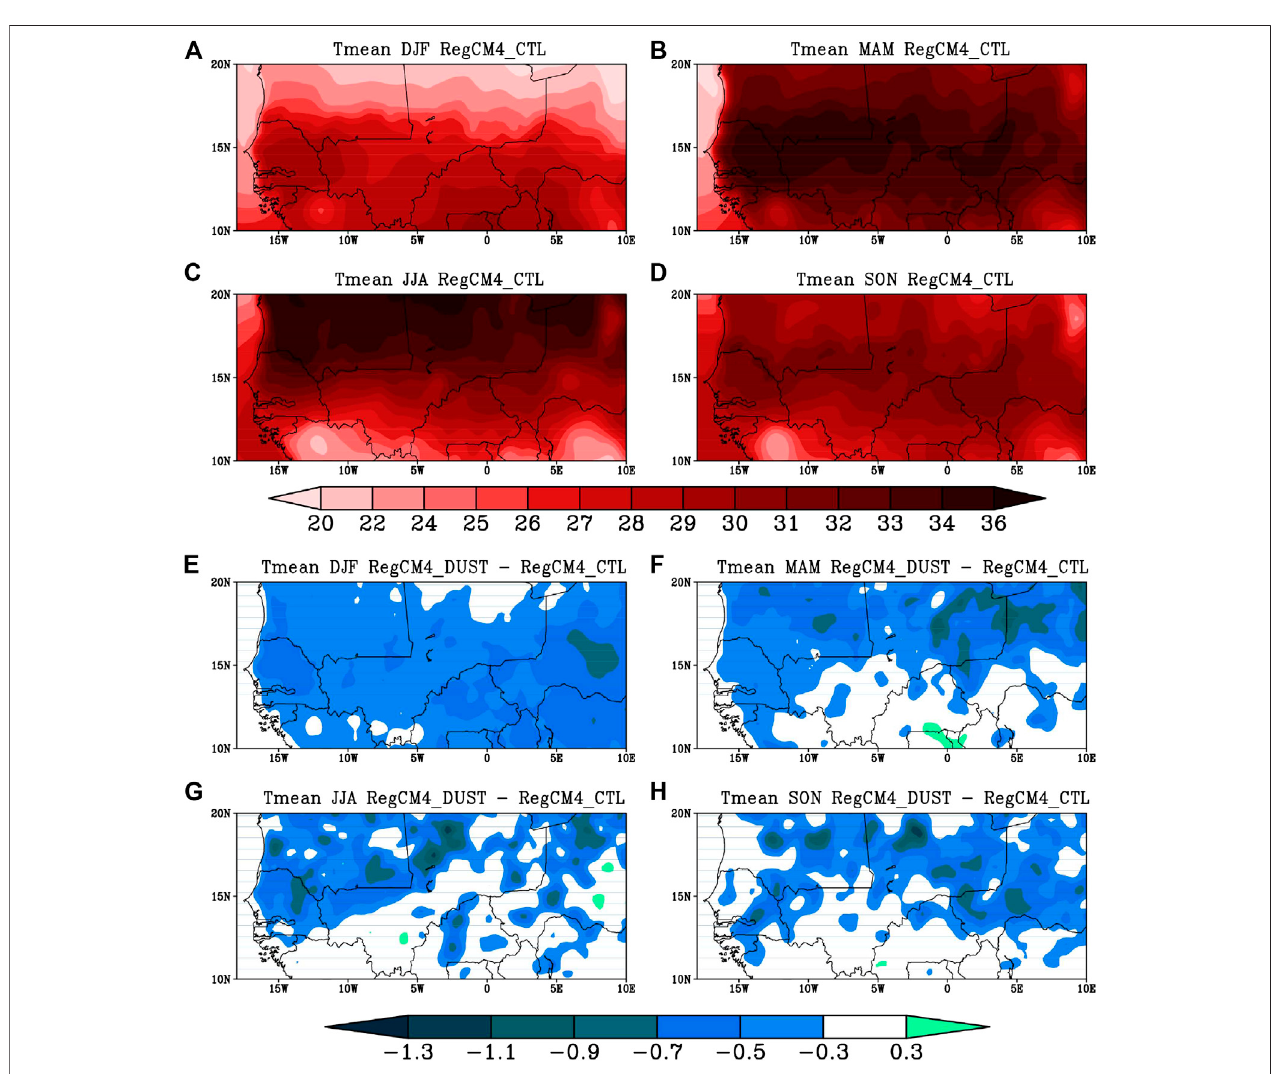
FIGURE4| Seasonalvariabilityofthemeansurfacetemperature (Tmean) ( ° C)averagedfrom2001to2010overtheSahel: (top) RegCM4_CTL, (down) difference between RegCM4_DUST and RegCM4_CTL.